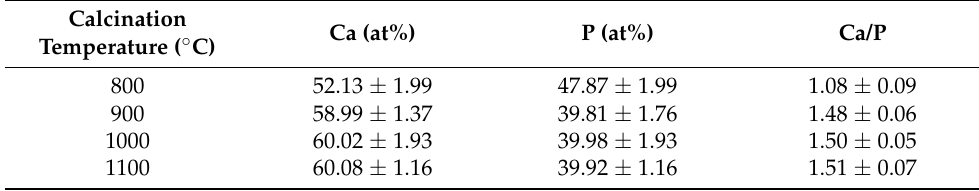
Table 2. Atomic compositions of β -TCP powders calcined at temperatures of 800, 900, 1000, and 1100 ◦ C derived from EDS